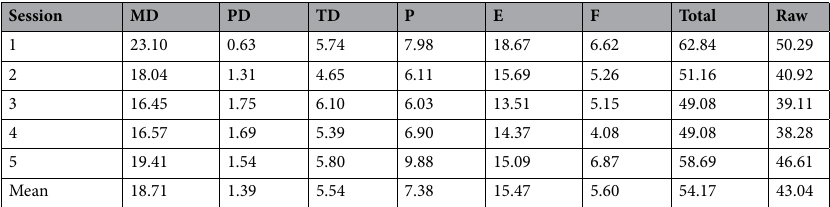
Table 3. NASA-TLX scores. MD = mental demands. PD = physical demands. TD = temporal demands. P = performance. E = effort. F = frustration. Total = global NASA-TLX score. Raw = unweighted global score.